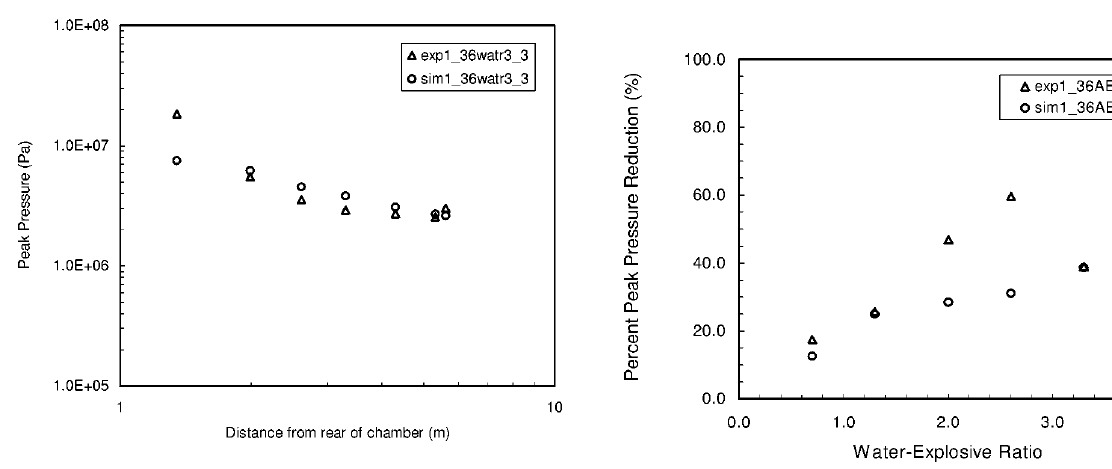
Fig. 11. Comparison between experiment and computation for 1.36 kg C4 charge detonation with water ( R = 2 : 6).